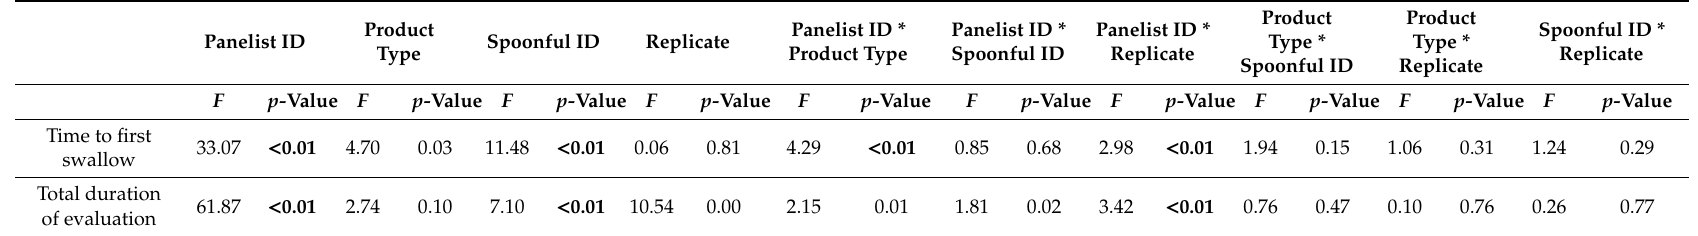
* corresponds to the interaction between replicate and product